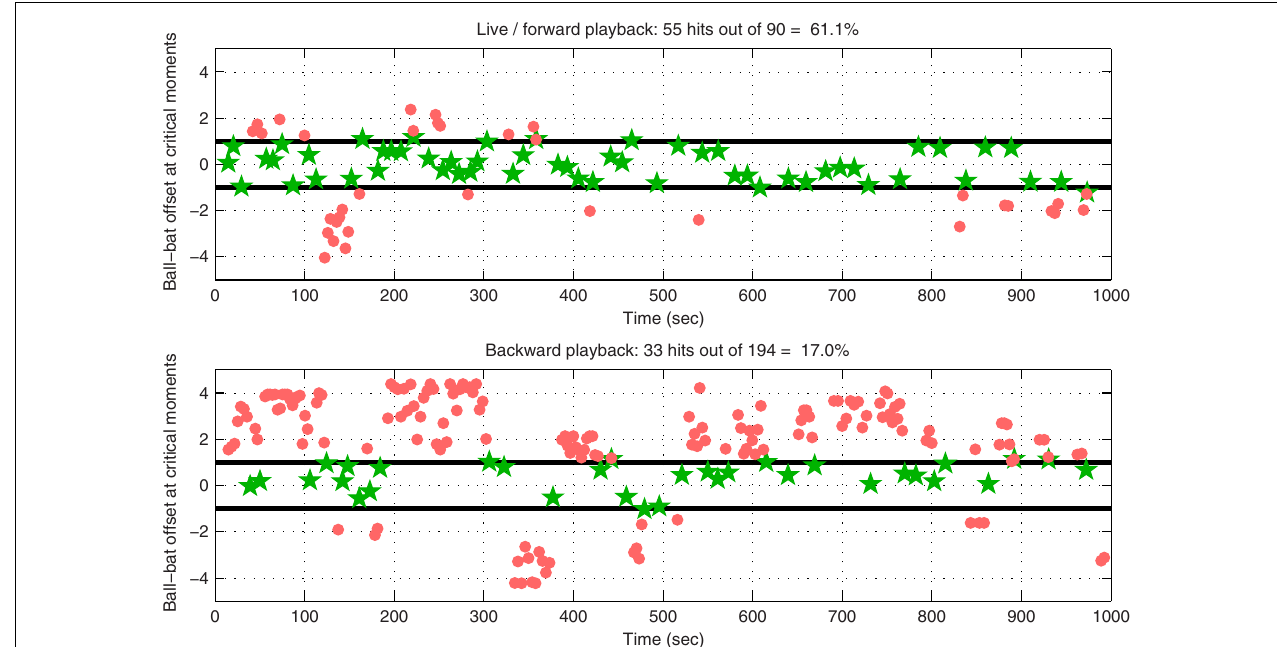
(the ball fell past the paddle, very soon falling off-screen and “re-spawning” to repeat the last second of its downward trajectory).The upper panel shows performance during forward playback of the EEG recorded during the game (results are identical to those obtained by analyzing bat and ball movements in the actual original game file), whereas the lower panel provides an estimate of chance performance by illustrating game performance when data are played